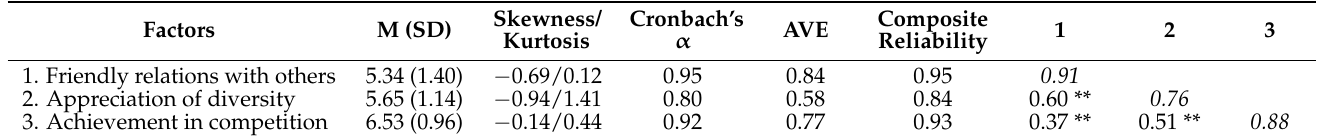
Table 4. Descriptive statistics, internal consistency, and validity analysis of the